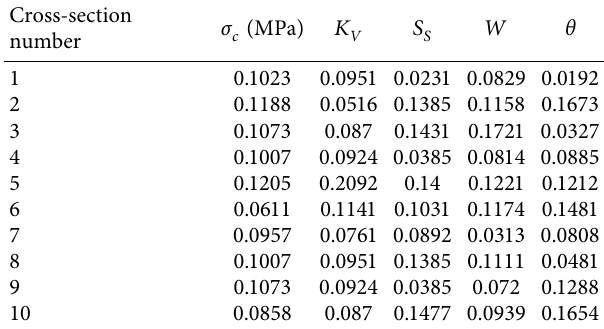
Table 7: The normalized comprehensive relative membership degree vector.